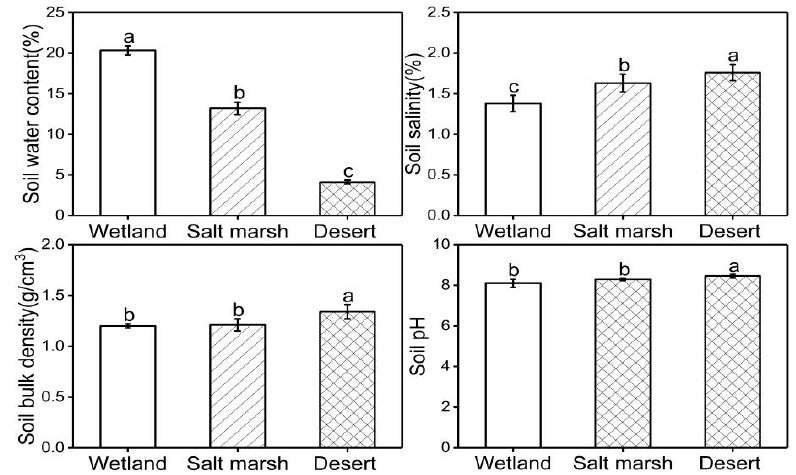
Figure 2. Characteristics of the soil environmental factors in different habitats (Error bars represent standard deviation. Different lowercase letters indicate significant differences between environmental gradients, p < 0.05).